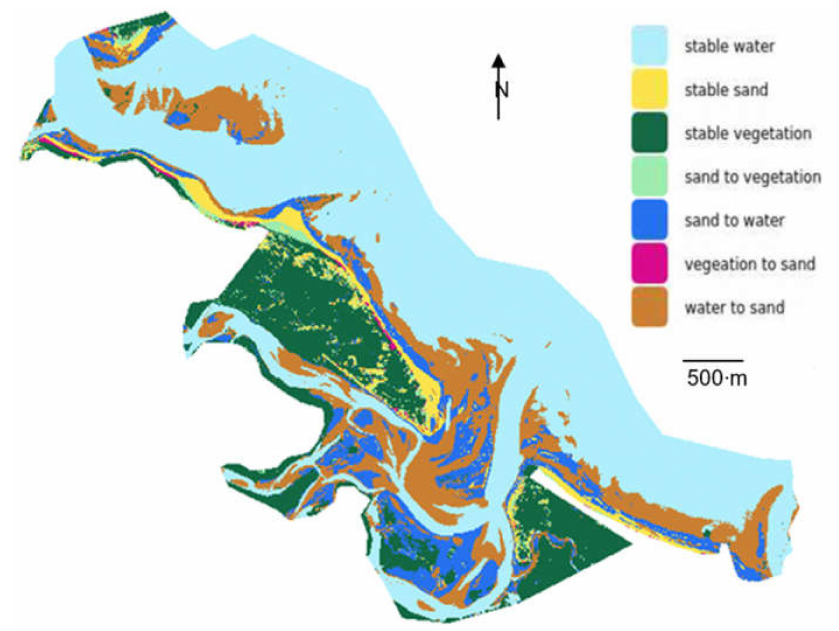
Figure 11. Image analysis (classification’s overall accuracy of 97%) using high-resolution satellite photographs shows how depositional environments at the study area changed from 2017 to 2019 (imagery is from PlanetScope satellite.